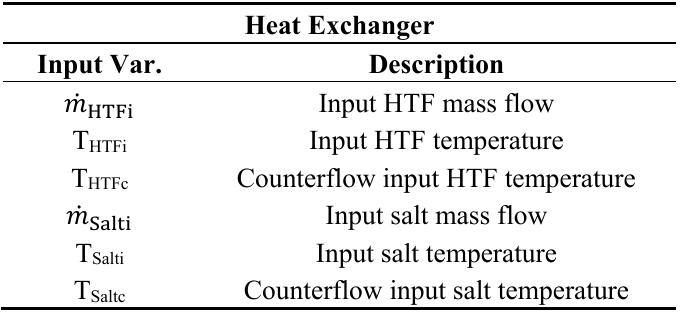
Table 9. Heat exchanger input variables.